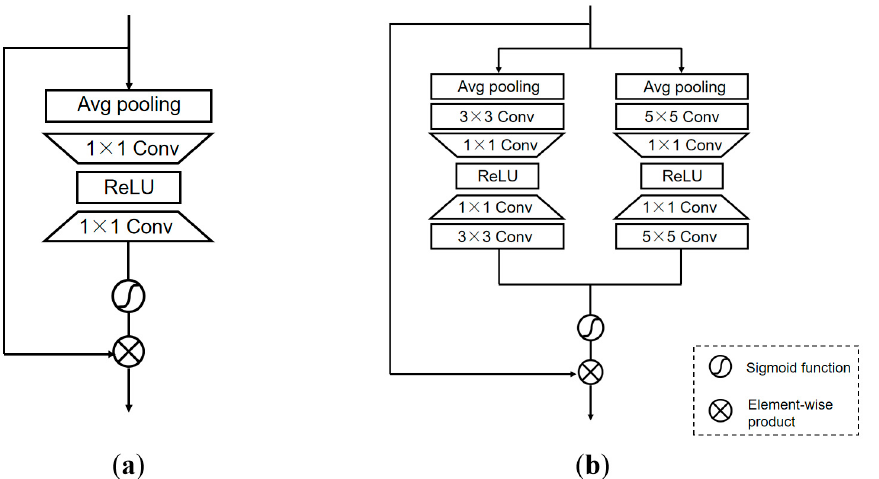
Figure 4. Different types of attention module: ( a ) Channel attention; ( b ) Multi-scale Attention block (MAB).